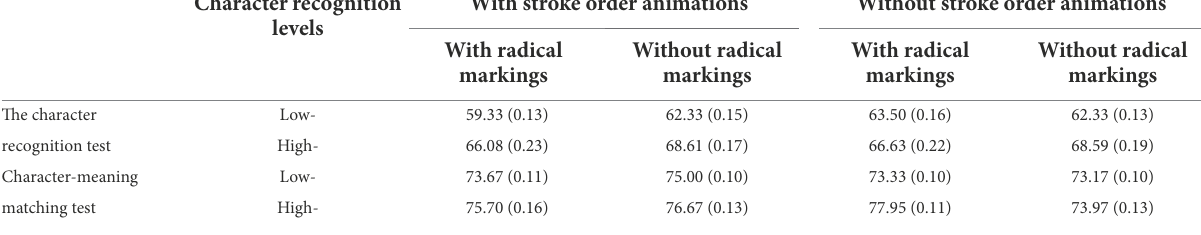
TABLE 3 Mean accuracy (%) and standard deviation (in parentheses) of the one-week delayed